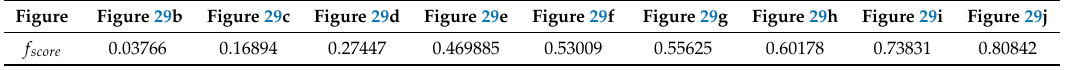
Figure 29. Images ( b – j ) correspond to different viewpoints of the element shown on image ( a ). The f score of each viewpoint is provided in Table 10. Table 10. The f score of viewpoints for inspecting the element of Figure 29a. Figure 29b Figure 29c Figure 29d Figure 29e Figure 29f Figure 29g Figure 29h Figure 29i Figure